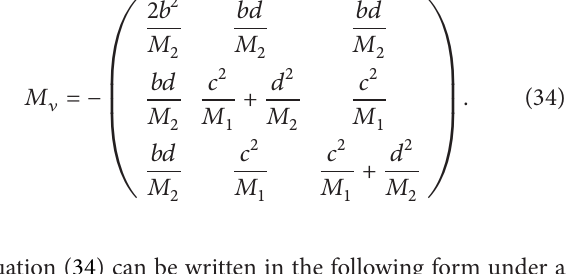
(middle), and 𝑚 𝛽𝛽 versus Σ𝑚 𝑖 (right) for Category 𝐴 (top) and Category 𝐵 (bottom)